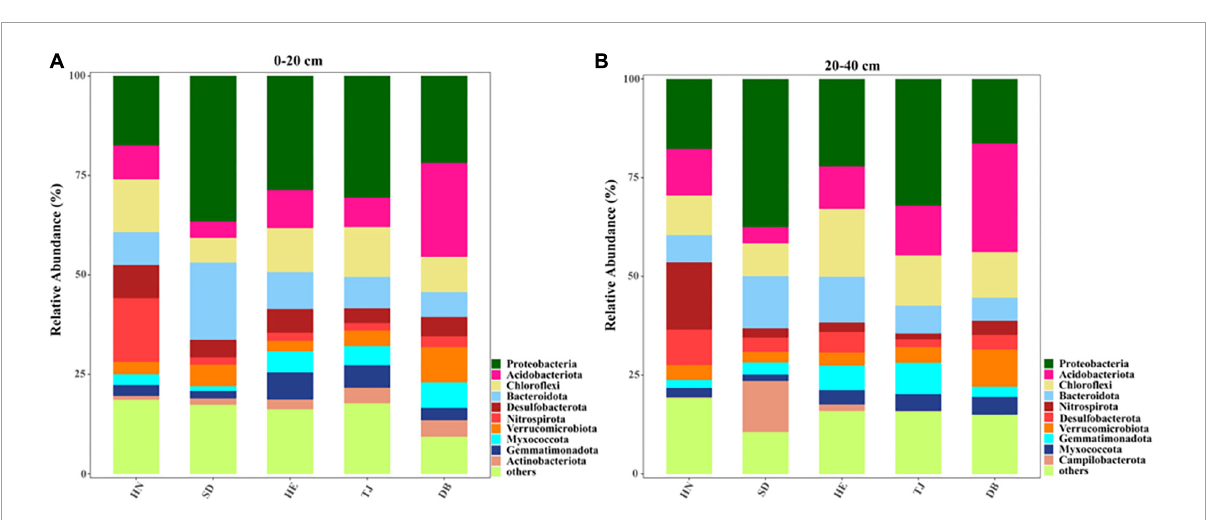
communities was significantly greater than that of soil layers ( Figure 5A ; R = 0.418, P = 0.001). LDA axes1 and LDA axes2 explained the differences of 66.96 and 23.81% for MP communities among different locations, respectively ( Figure 5B ). HE and HN were significantly